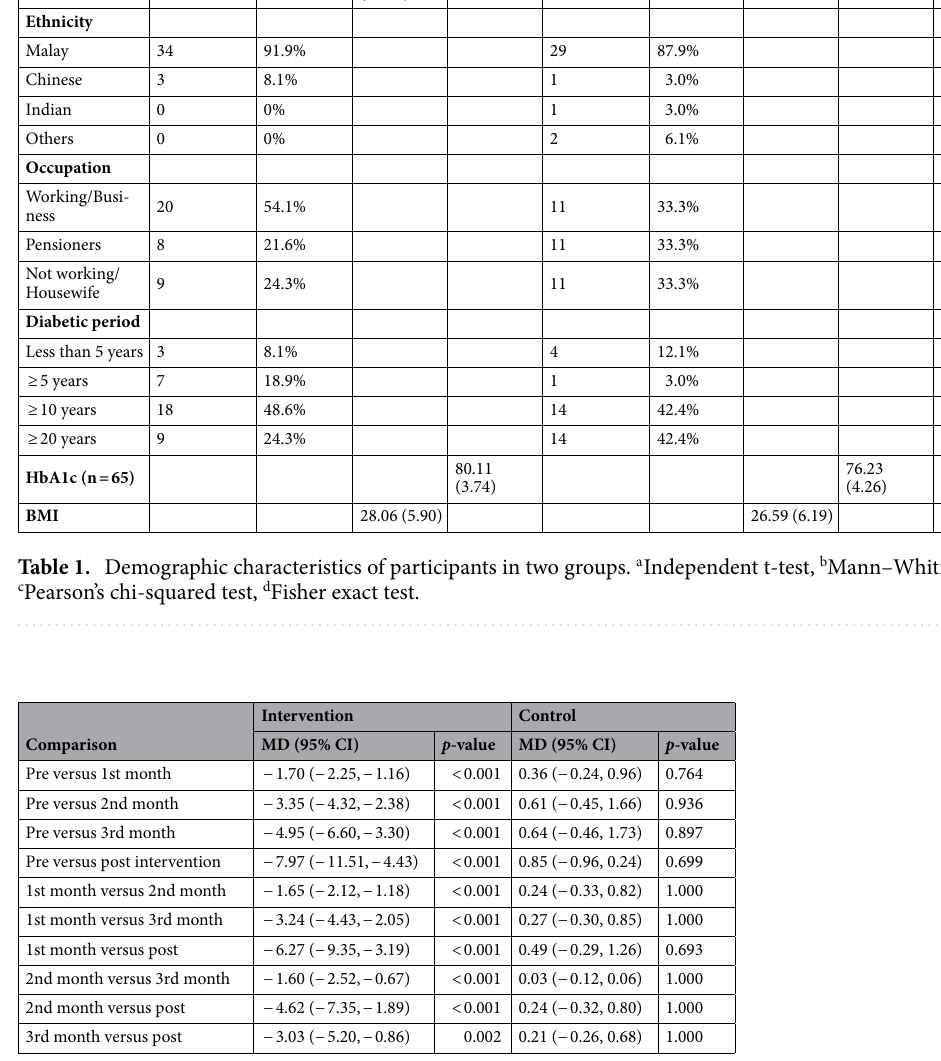
Table 2. Comparison of ESE-M scores within intervention and control groups based on time.